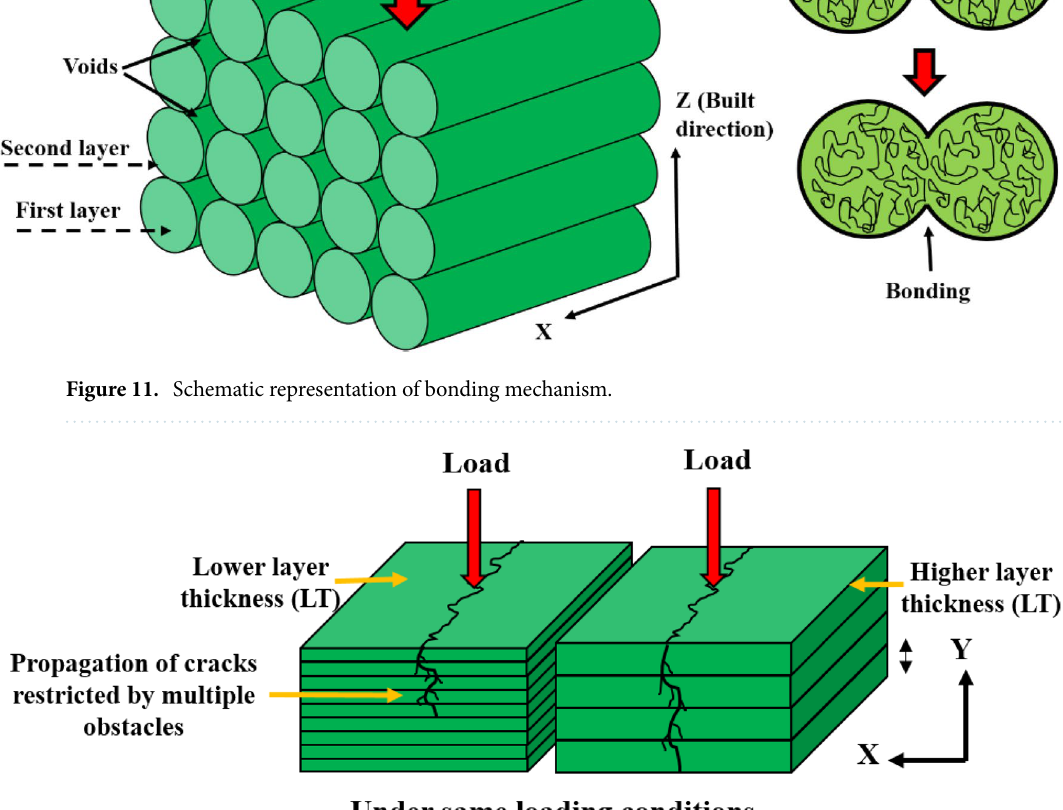
Figure 12. Schematic representation on influence of layer thickness on crack